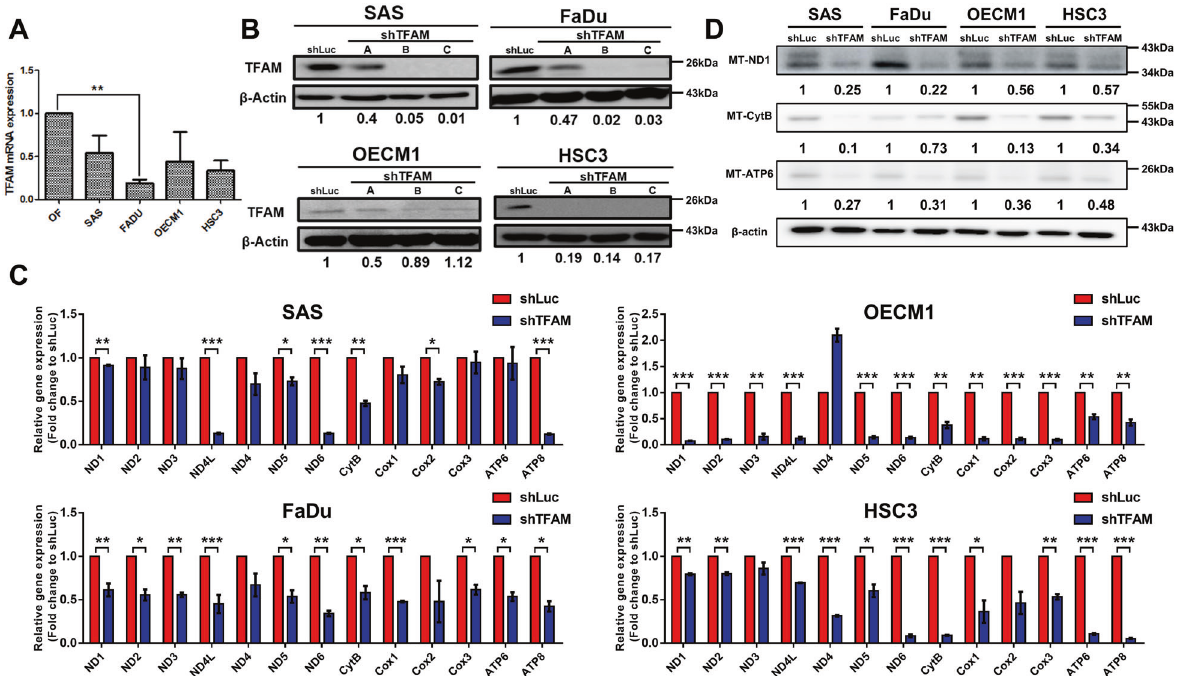
Fig. 1 TFAM alterations lead to functional mtDNA change in HNC cells. A Real-time RT-PCR analysis showed decreased TFAM mRNA expression in HNC cells compared with OFs. B Western blot analysis showed effective changes of TFAM expression in shRNA-mediated TFAM silencing. The clone C shTFAM infected SAS/FaDu cells, clone B shTFAM infected OECM1 cells and clone A shTFAM infected HSC3 cells are used for the experiments. Functional knockdown is evident using ( C ) real-time RT-PCR and ( D ) Western blot analysis showing signi fi cant downregulation of mtDNA-encoded ETC subunit genes in TFAM silencing HNC cells. Different ETC complex genes including Complex I (ND1, ND2, ND3, ND4, ND4L, ND5, ND6), Complex III (CytB), Complex IV (E, Cox I, Cox II, Cox III) and Complex V (ATP8, ATP6) are indicated. Quanti fi cation of real-time RT-PCR analysis is represented as the fold changes of ETC gene expression in TFAM silencing (shTFAM) over control (shLuc) HNC cells. Quanti fi cation of Western blot analysis is represented as the fold changes of TFAM protein expression in TFAM silencing (shTFAM) over control (shLuc) HNC cells using Image J. Data are presented as Mean ± SEM ( N = 3 independent biological replicates). * p < 0.05, ** p < 0.01, *** p <